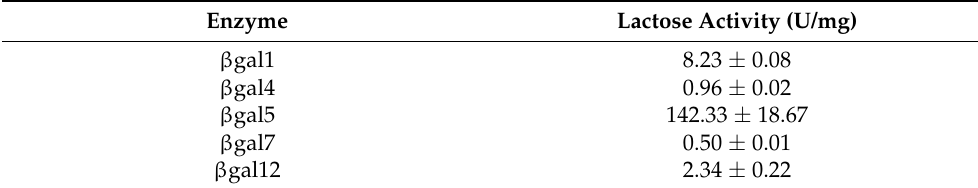
Table 4. β -Galactosidase activity on lactose. Data were obtained from biological replicates ( n = 3). Enzyme Lactose Activity (U/mg) β gal1 8.23 ±